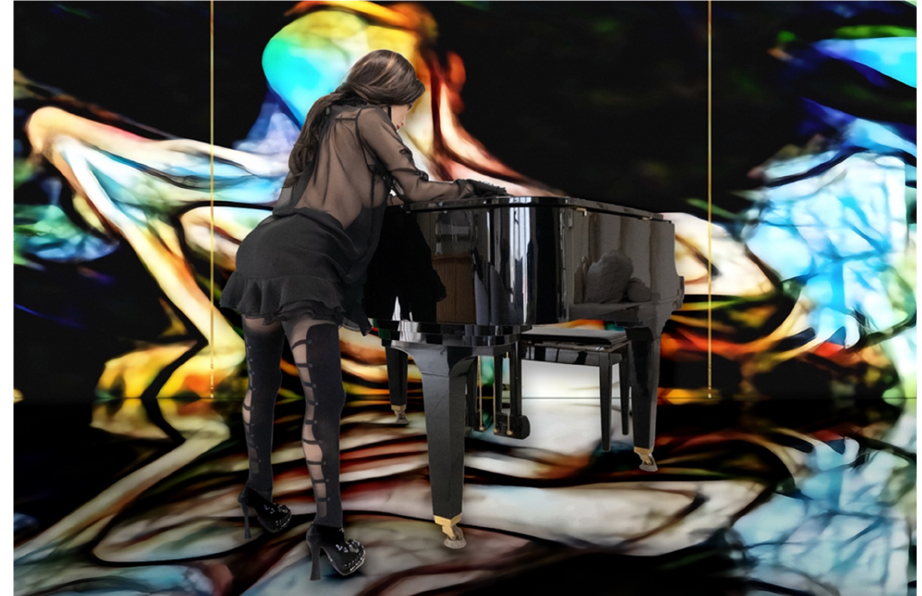
Figure 8. Madeleine + I desire not to be so heavy-souled. By Graeme Revell, 2022. Photograph, GPT-2/DALL-E2 image and text.